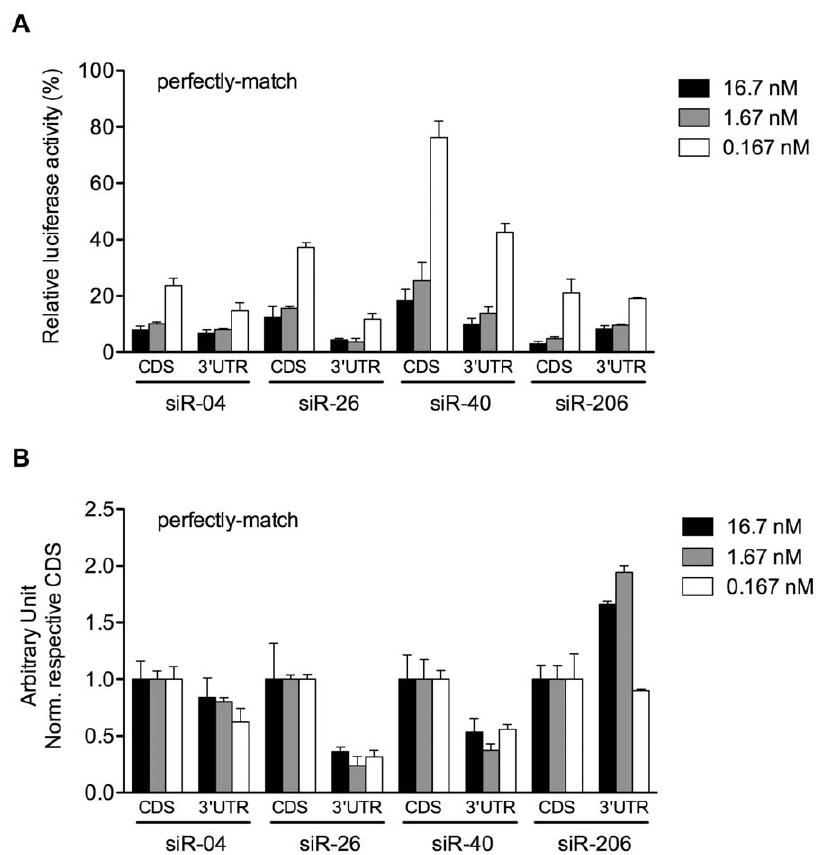
Figure 5. siRNA towards perfectly matched site was not necessarily acting better in 3 9 -UTR in comparison to CDS. Silencing efficacies of four siRNAs (siR-04, 26, 40, 206) on perfectly matched targets in CDS versus 3 9 -UTR were shown as (A) original data and (B) normalized data, by using varying siRNA concentrations from 0.167 to 16.7 nM. The normalized data were calculated by normalizing each original silencing efficacy of siRNA towards 3 9 -UTR site to that towards CDS site. The lower bars indicated siRNA had stronger silencing activities. Error bars represented SD. Data were average values of assays in triplicates, and all experiments were repeated at least twice.